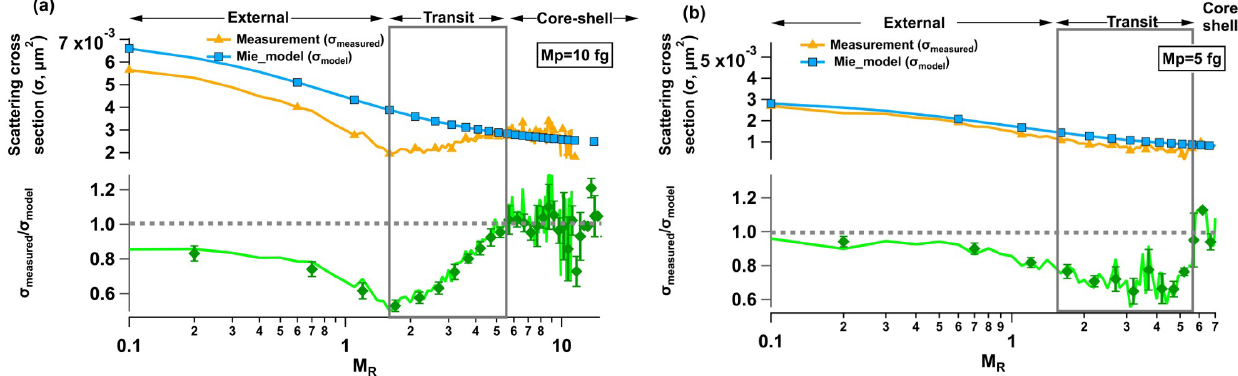
Figure 10. (a) Scattering cross section of rBC-containing particles as measured by SP2 (yellow line) and calculated by Mie theory (blue line), assuming a core–shell structure. Bottom panel: the ratio (green line) between these two scattering cross sections at a CPMA set point of 10fg as a function of M R (the mass ratio of nonrefractory matter to rBC). (b) The same as (a) but for a CPMA set point of 5fg.